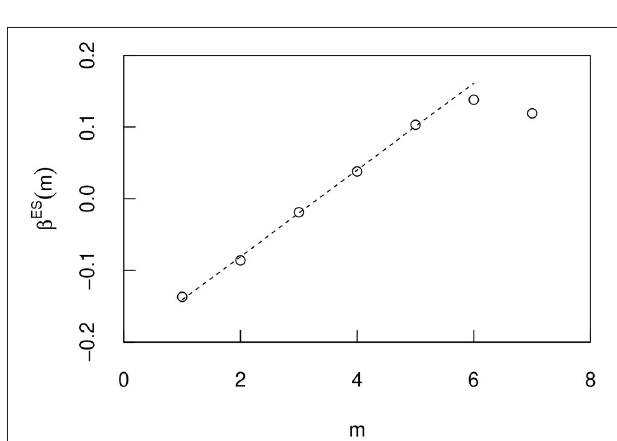
FIGURE 12 | Results of simulation of the growth of the geometric mean of the urban population using values randomly sampled from real data in Italy. Original ( T = 1) populations x 1 are divided into logarithmically equally sized bins: x 1 ∈ [10 0.5( m − 1) + 2 ,10 0.5 m + 2 ) ( m = 1,2, ··· ,7). Points in the figure indicate m = 1,2, ··· ,7 in order from the bottom.